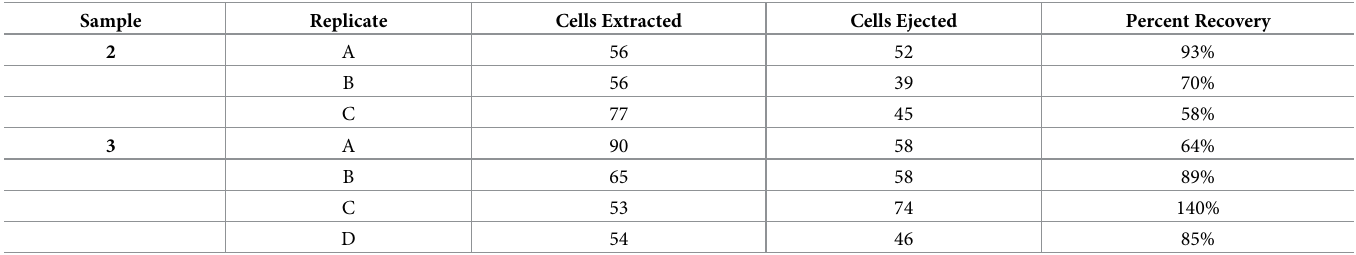
Table 1. Recovery of optical tweezer-separated spermatozoa from mixed vaginal:Sperm samples.